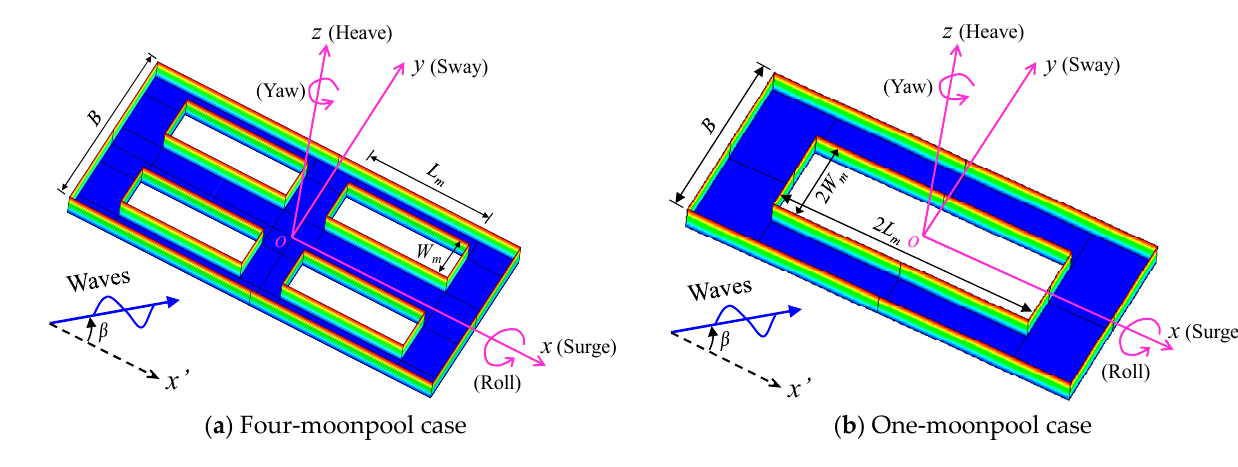
Figure 2. Sketch of calculation model and definition of coordinate system.